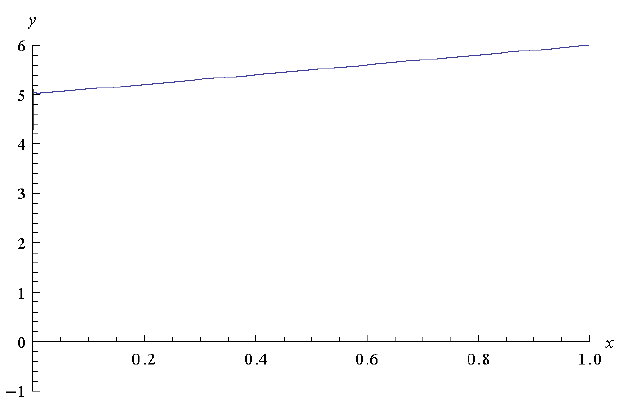
Figure 7. Approximate solution for (cid:101) = 0.0001.